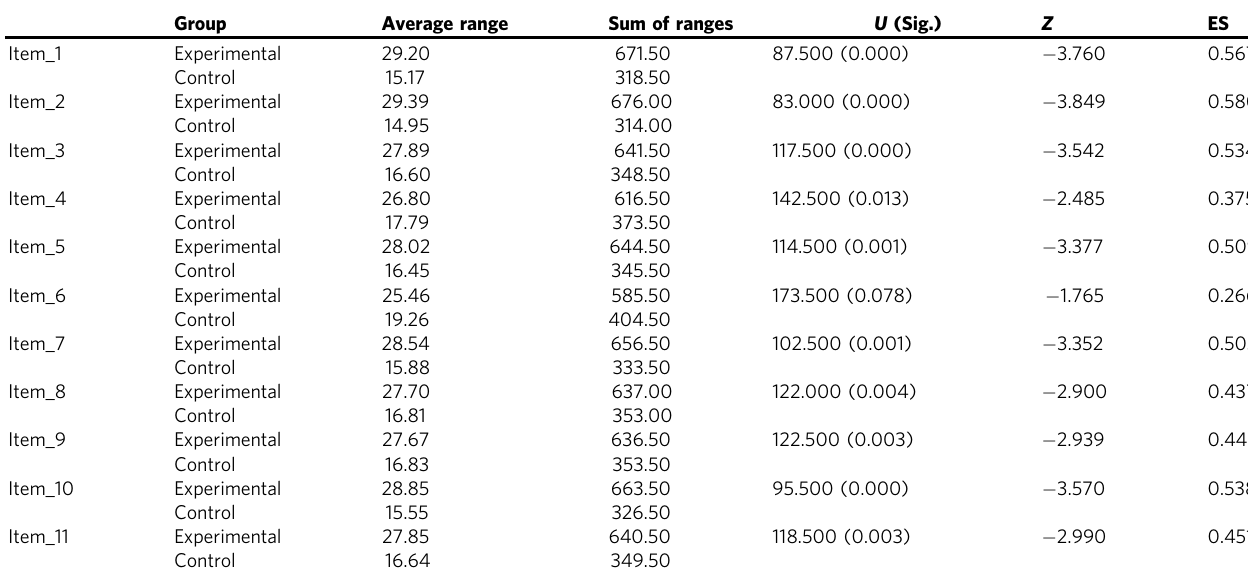
Table 8 Mann – Whitney U test of the posttest between the control group and the experimental group with their respective effect